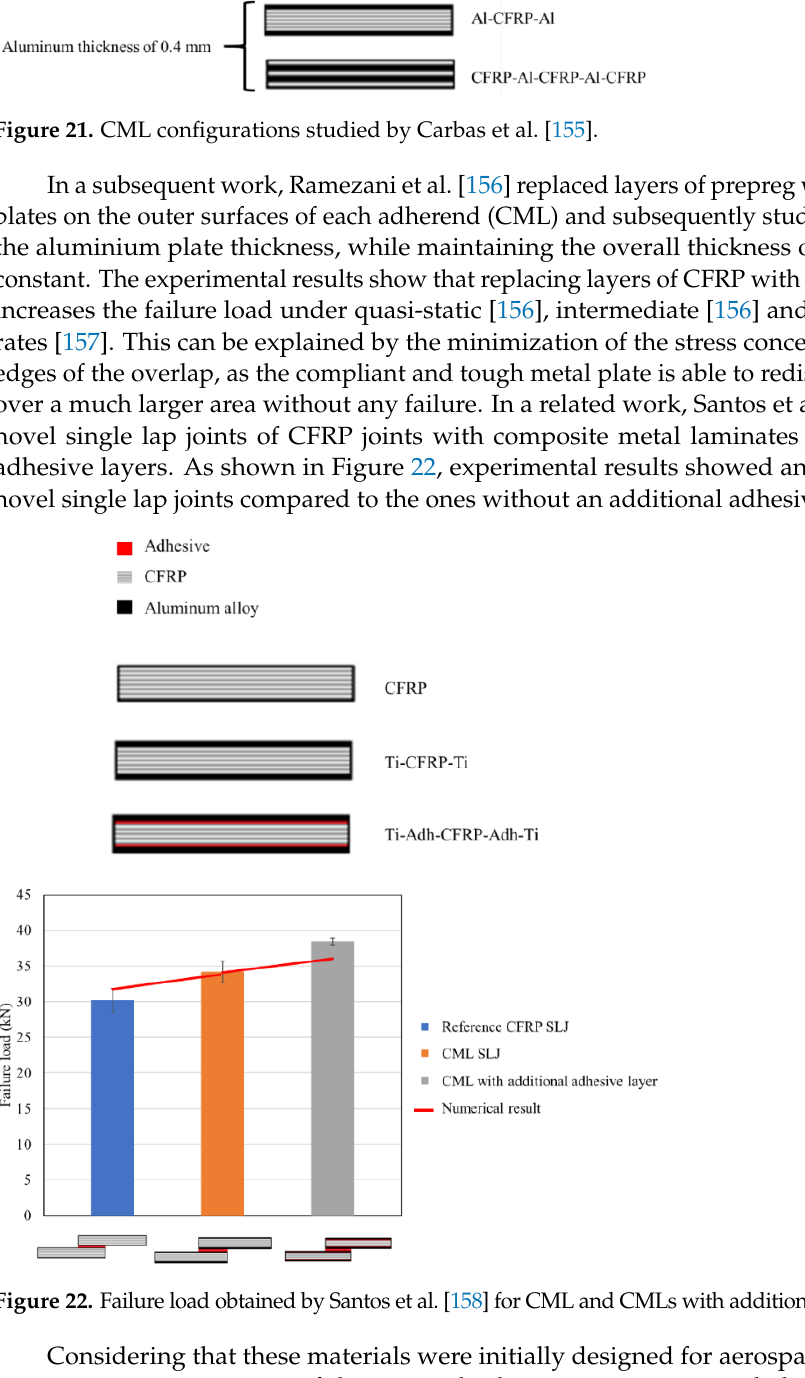
Figure 21. CML configurations studied by Carbas et al. [155].